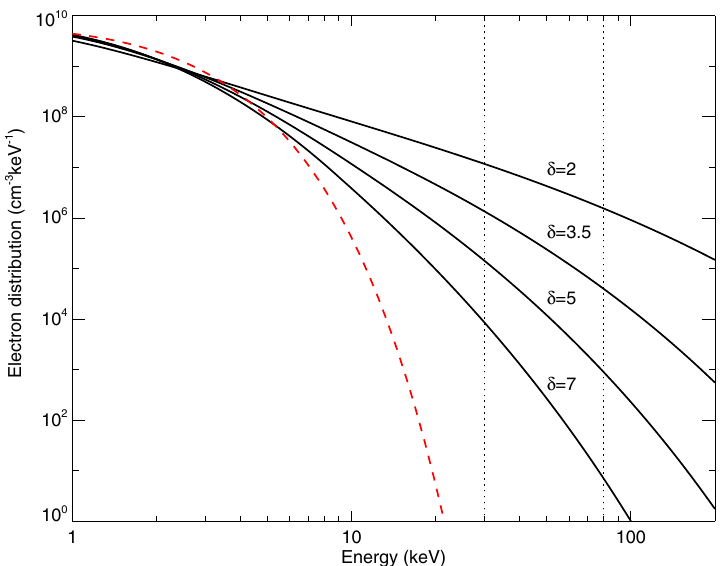
Fig. 31 Still from a movie: The particle distribution versus energy in time ( blue in the movie) as described by Eq. (9). A tail develops out of the thermal distribution ( red ). The solution becomes stationary after